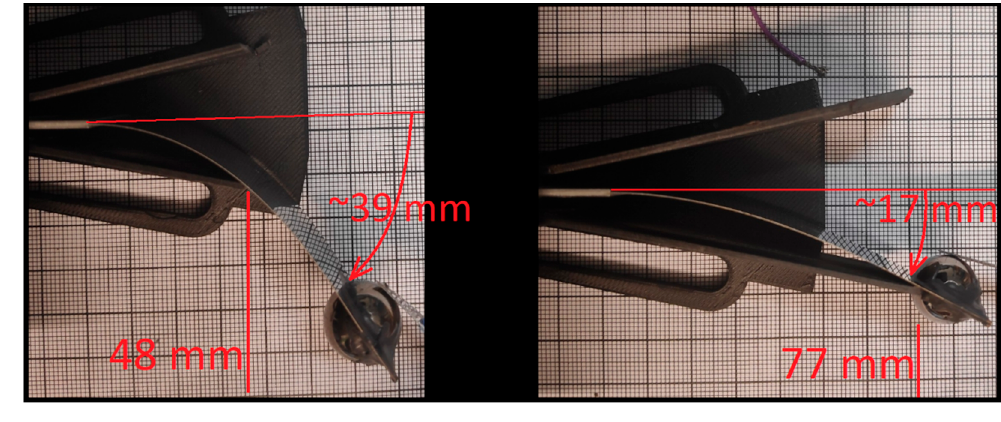
Figure 6. Tip mass movement with different limiter.